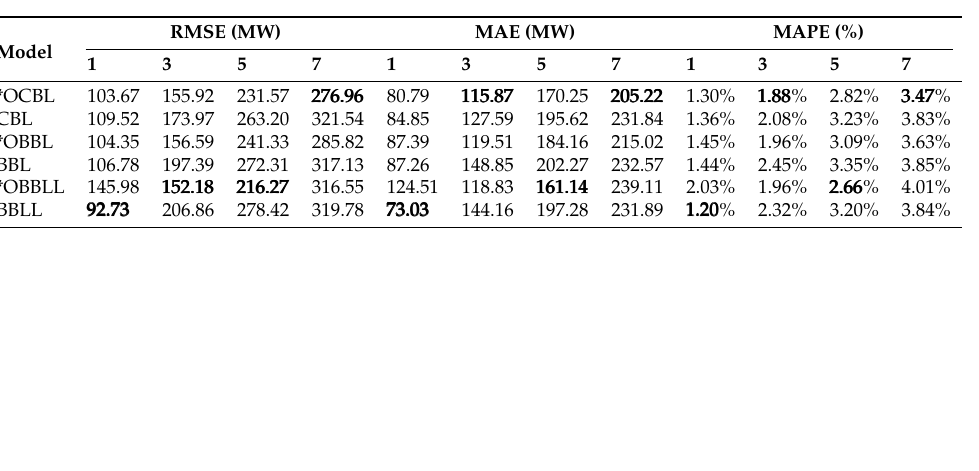
Figure 11. The MAE metric comparison of three groups of models, respectively, in future steps 1, 3, 5, and 7 in Queensland in 2019. The dotted line divides the different comparative model groups. In each comparative model group, different colors represent different steps. The model with NODE is on the left side and the model without NODE is on the right side. Table 2. Experimental results: average RMSE, MAE, and MAPE in 2019. * indicates the model contains NODE